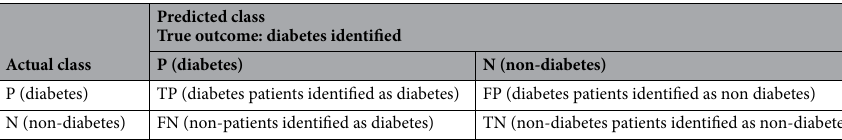
Table 2. Confusion matrix framework for diabetes diagnosis.